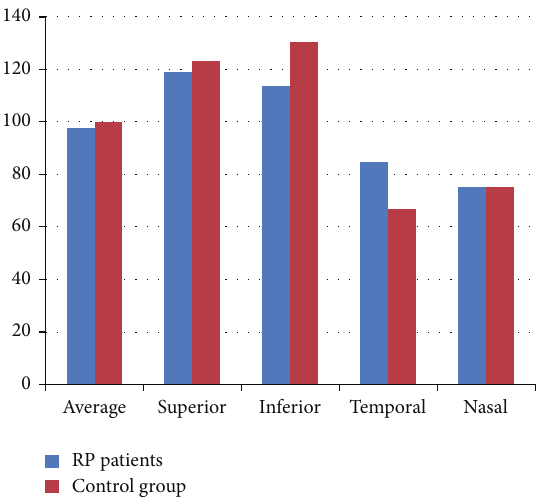
Figure 2: Distribution of RNFL thickness between RP patients and control